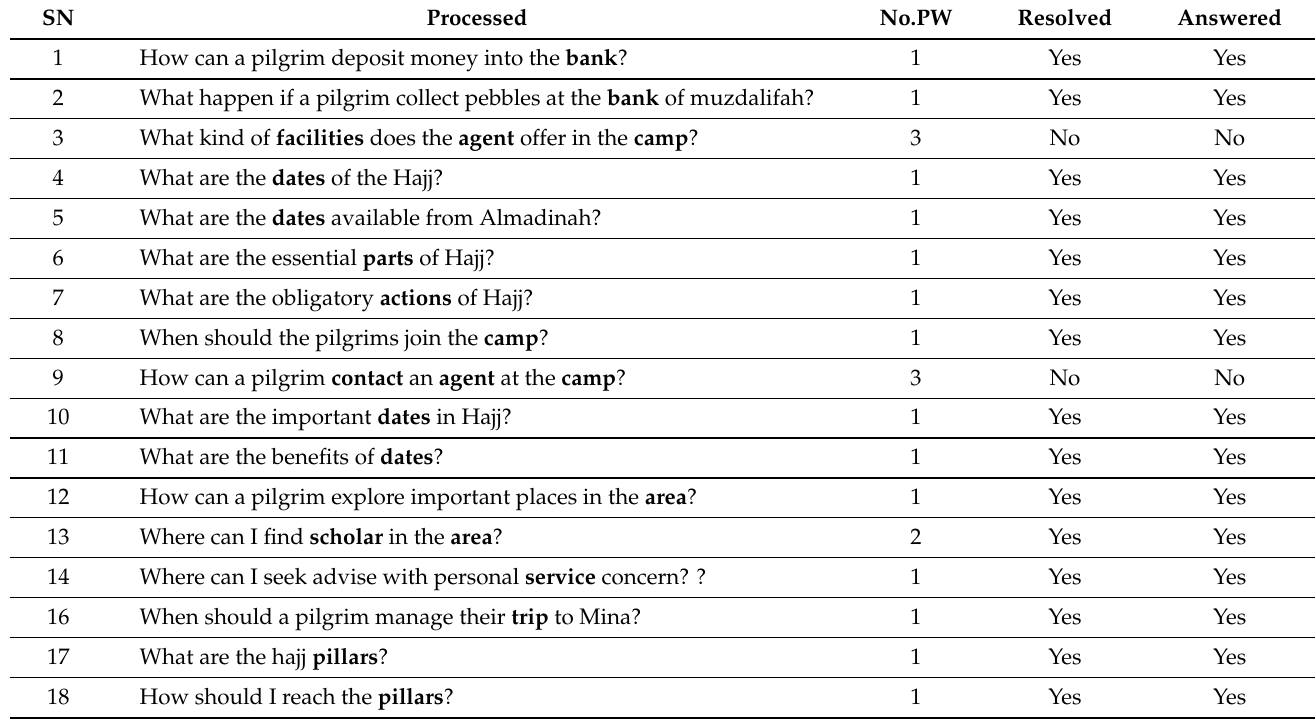
Table 1. Sample of the posed NL questions (Processed), number of polysemous word (No.PW), resolved, and answered. SN Processed